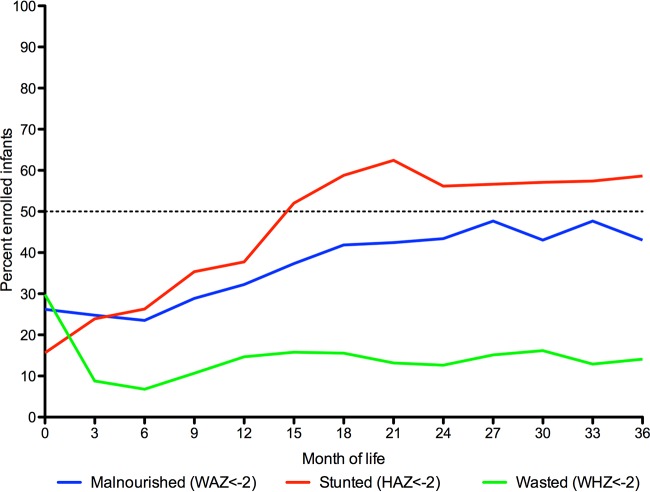
Longitudinal monitoring of infant anthropometry in the first 3 years of life. To estimate the trajectory of changing nutritional status, infant anthropometric measures were tracked at 3-month intervals in the first 3 years of life. The percentages of the population that were malnourished (WAZ, <−2), stunted (HAZ, <−2), and wasted (WHZ, <−2) are plotted at each 3-month time point from birth to age three.